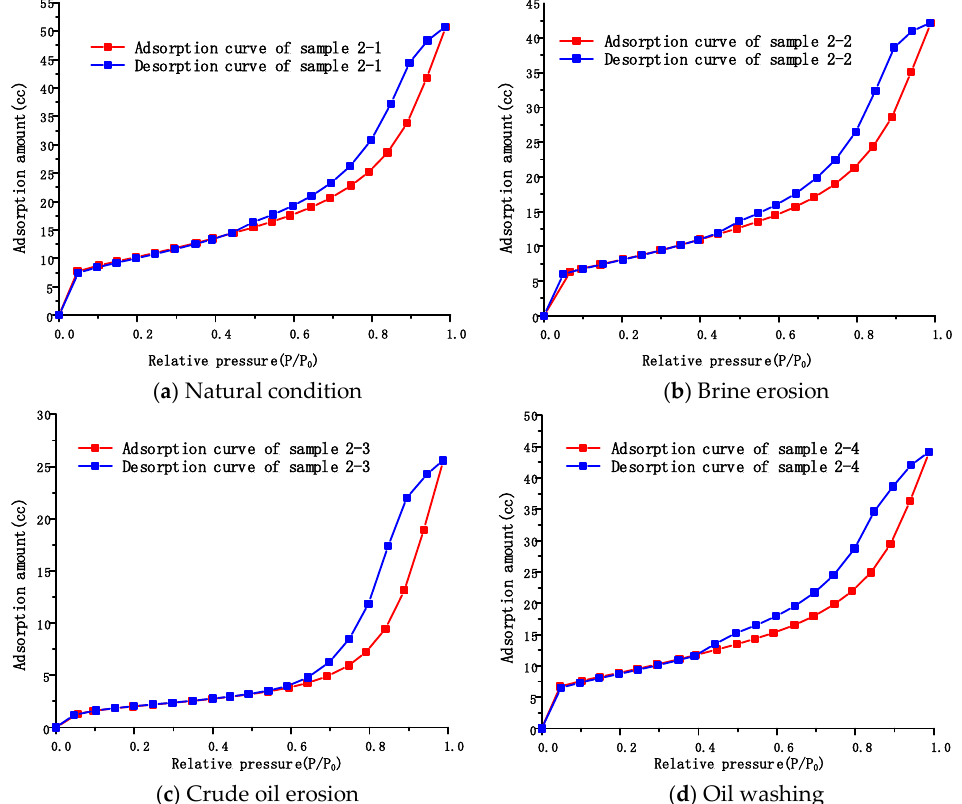
Figure 7. The adsorption isotherms of interlayer samples under different conditions.